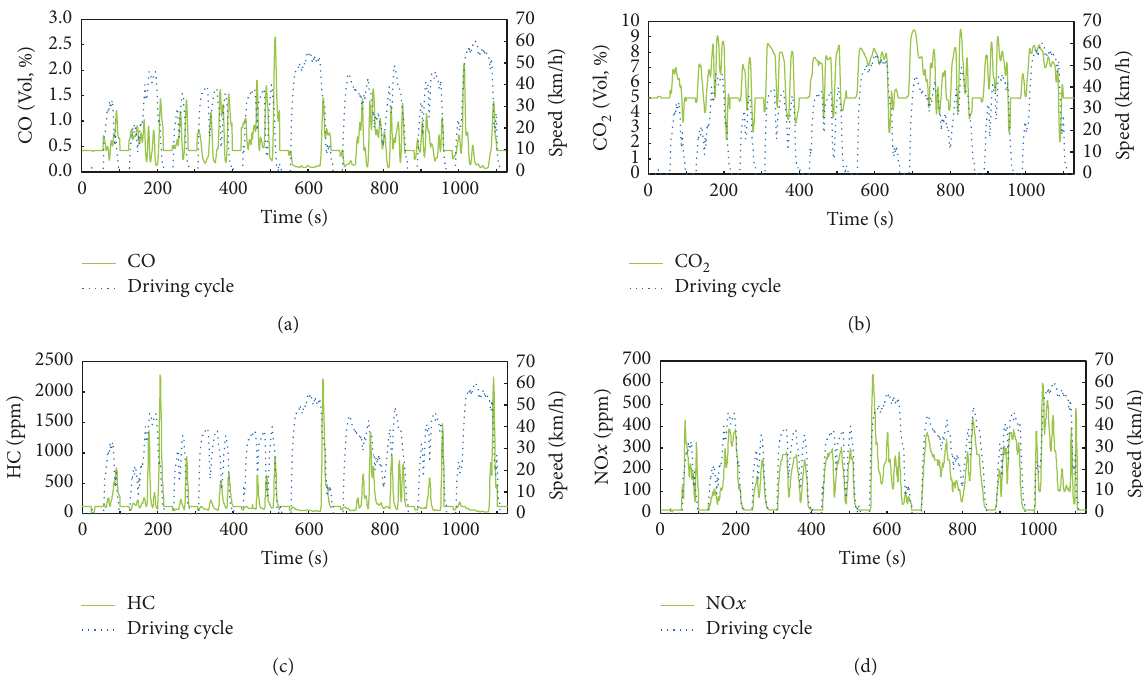
Figure 3: Motorcycle speed-time profile with exhaust